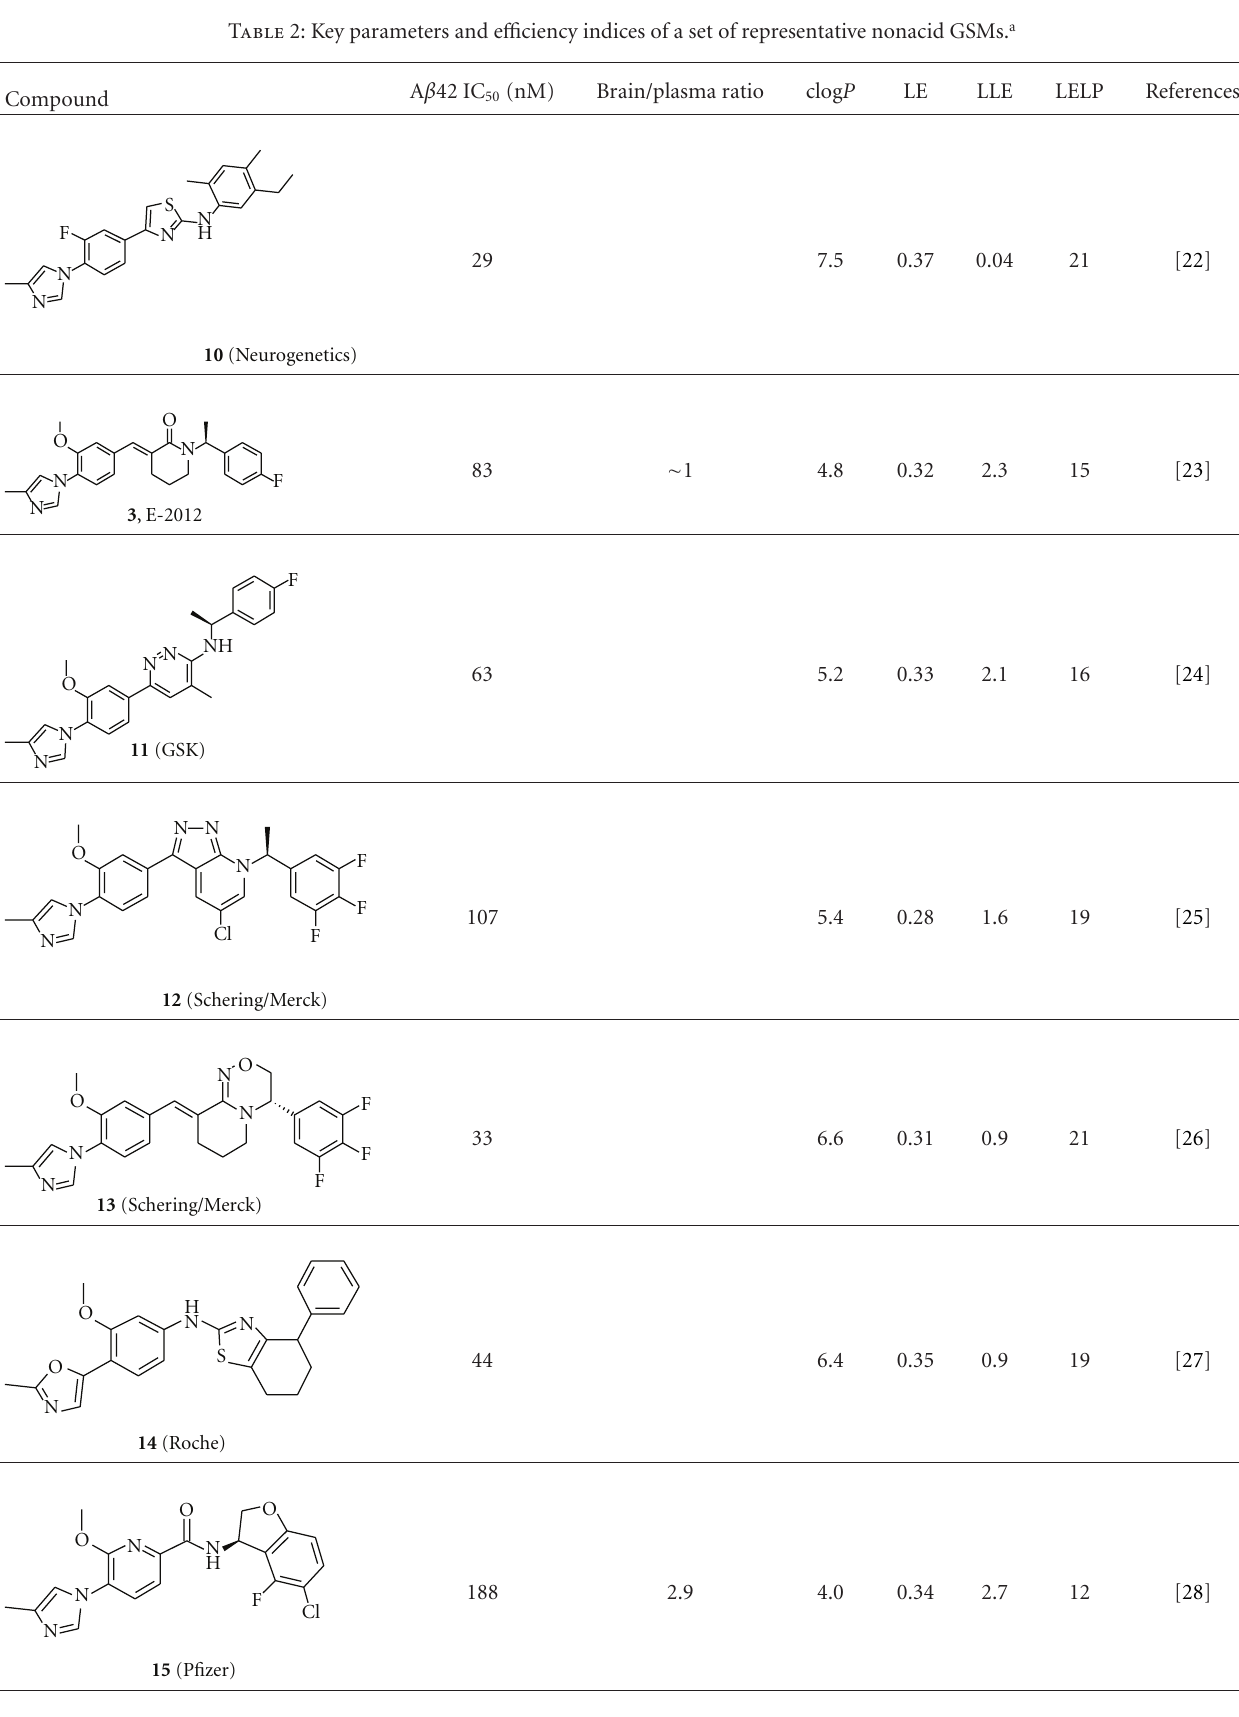
Table 2: Key parameters and e ffi ciency indices of a set of representative nonacid GSMs.